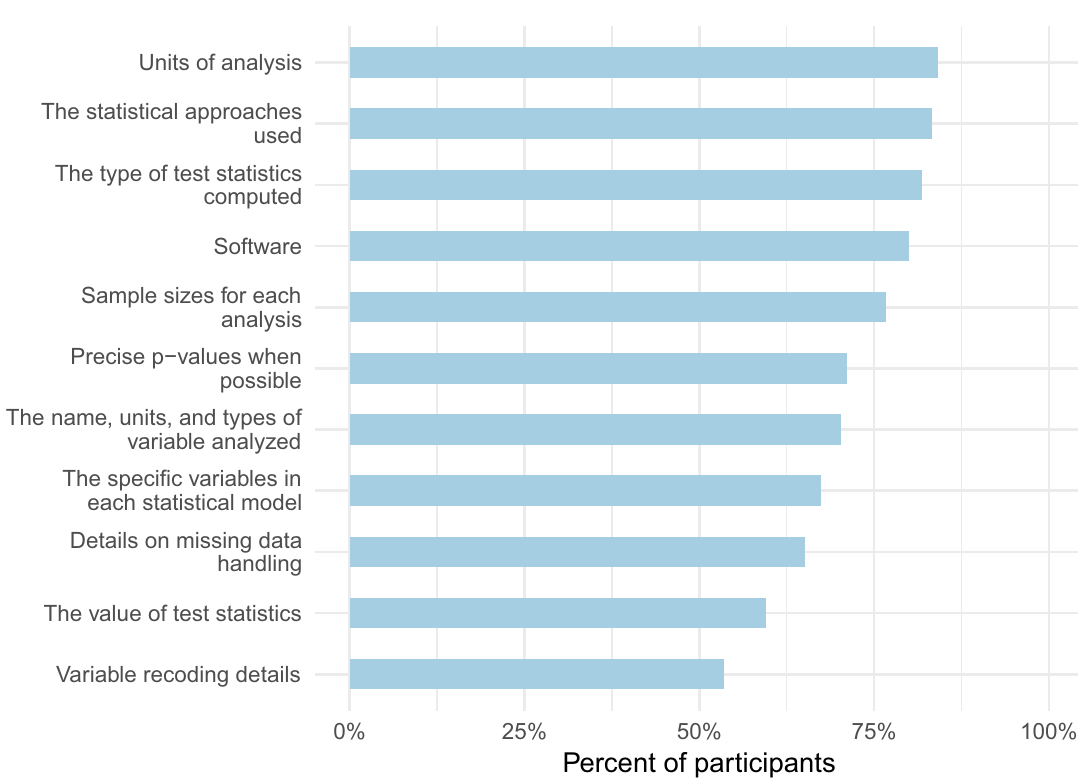
Fig 3. Percentage of participants who included each of 11 details that could facilitate reproducibility in recent publication or report. These responses are from the reproducibility of statistical analyses section of the